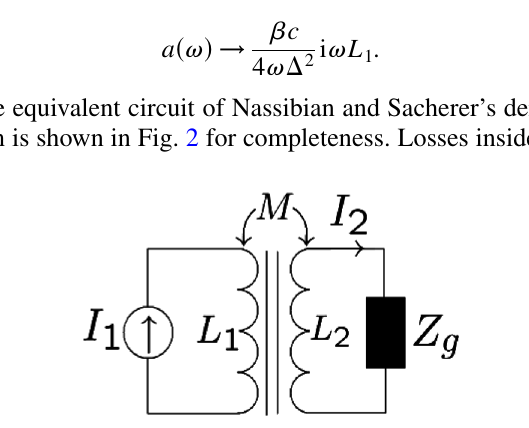
FIG. 1. Black box picture of the kicker module: U the local voltage between the extremes of an infinitesimal current segment of the twin-wire excitation, with current I q e (cid:4) i kz . U is the voltage between the PFN kicker plugs. With the 2 lumped PFN impedance Z tive current value.